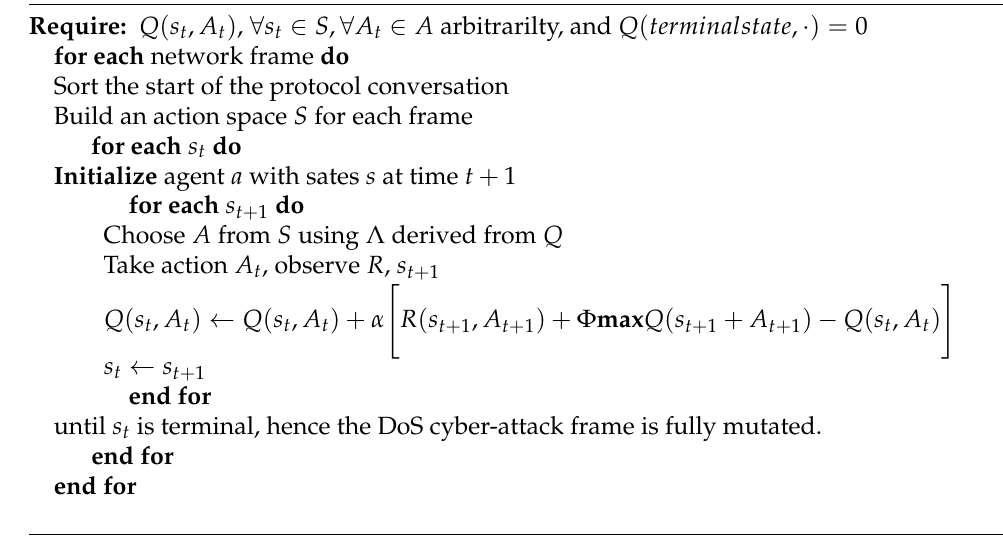
Algorithm 2 Learning process, out-of-policy for mutating DoS cyber-attacks frames